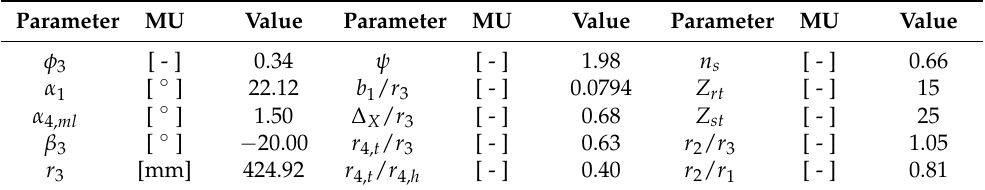
Table 7. Radial turbine design output: β 3 represents the optimal incidence angle [29] for a radial blade ( β 3, M =